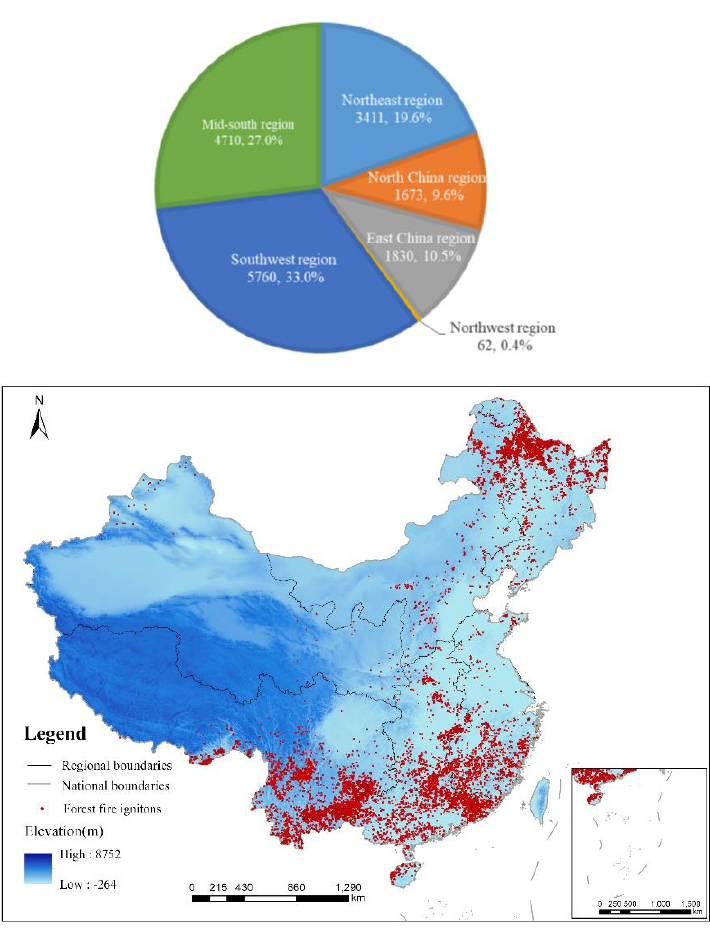
Figure 2. Distribution of the number, proportion and location of forest fire ignitions in six geographical regions from 2010 to 2016 .